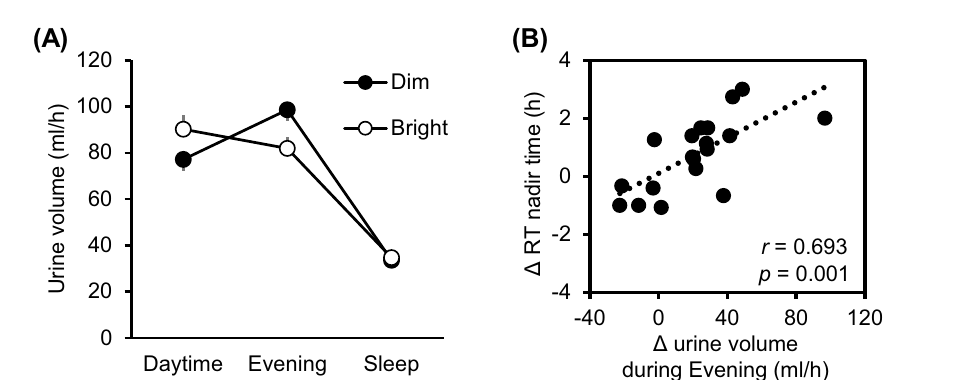
Figure 3. Effects of bright versus dim daytime light exposure on urine excretion variables. ( A–F ) Mean urine volume, Na, K, Cl, UA, and urine osmolality values ± SEMs, respectively, over time. Linear mixed model and Bonferroni post hoc tests were used ( N = 19); * p < 0.05.